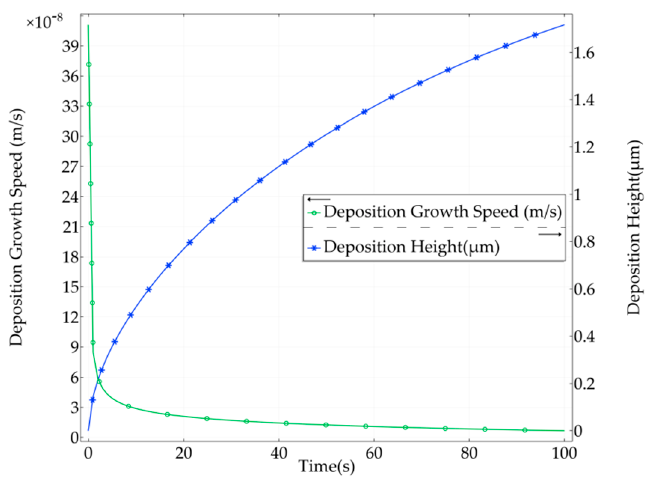
Figure 9. The relationship curves of deposition growth speed and height corresponding to time.